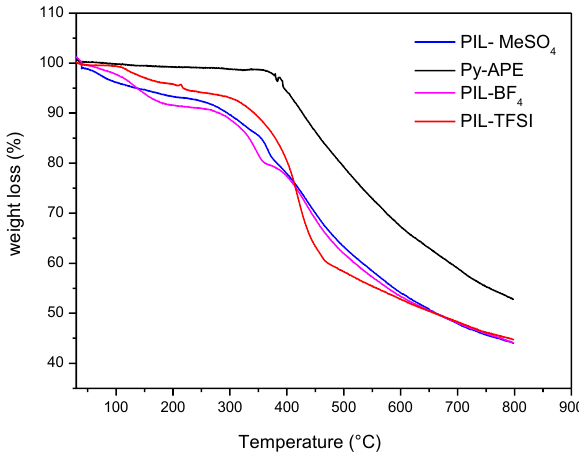
Figure 3. TGA curves of precursor polymer Py-APE and its corresponding PILs with different counter anions.